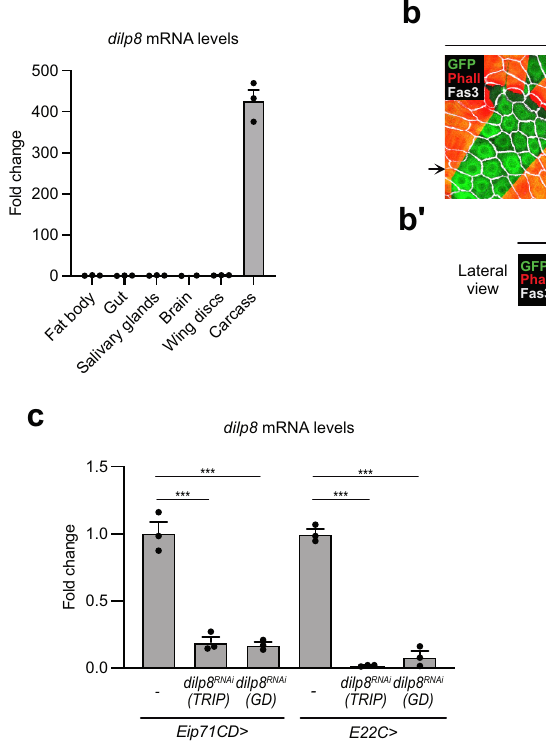
( Eip71CD > EcR RNAi pan and E22C > EcR RNAi pan ) and observed a strong